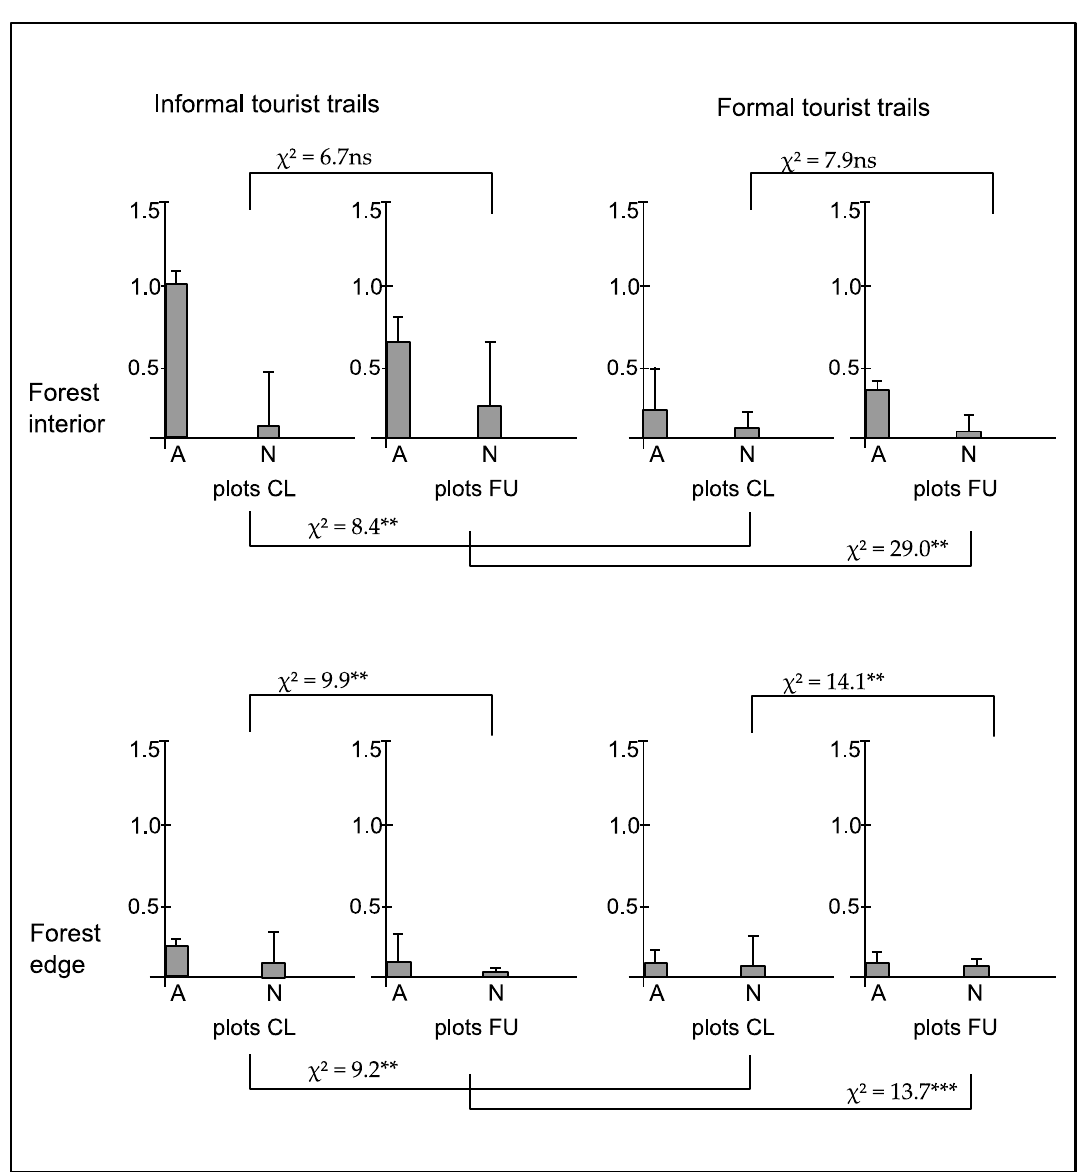
Figure 12. The mean cover-abundance degree of alien (A) and native (N) species (±SD) per plot in closer (CL) and further (FU) plots located along informal (width < 50 cm) and formal (width > 150 cm) tourist trails within the forest interior and forest edge sites. The statistical significance level is explained in Figure 2.